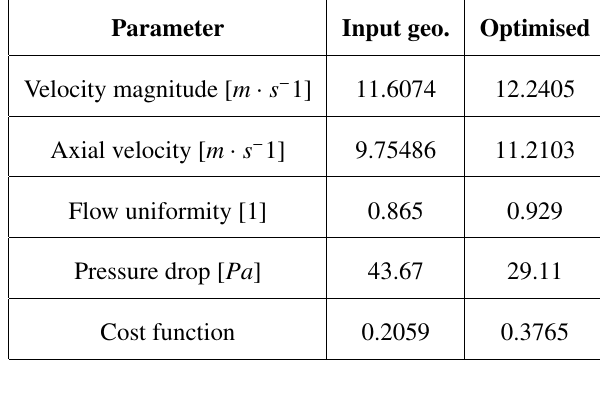
Fig. 3. Distance of maximum velocity behind nozzle .